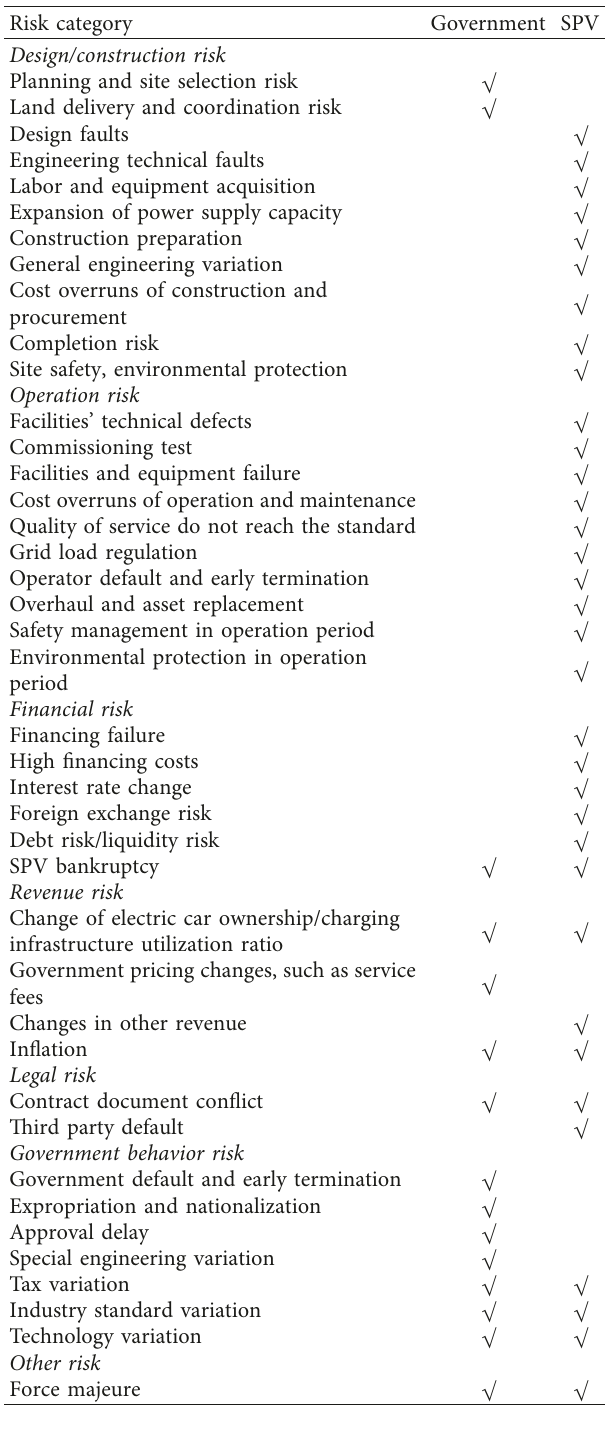
Table 2: Risk allocation in the Anqing